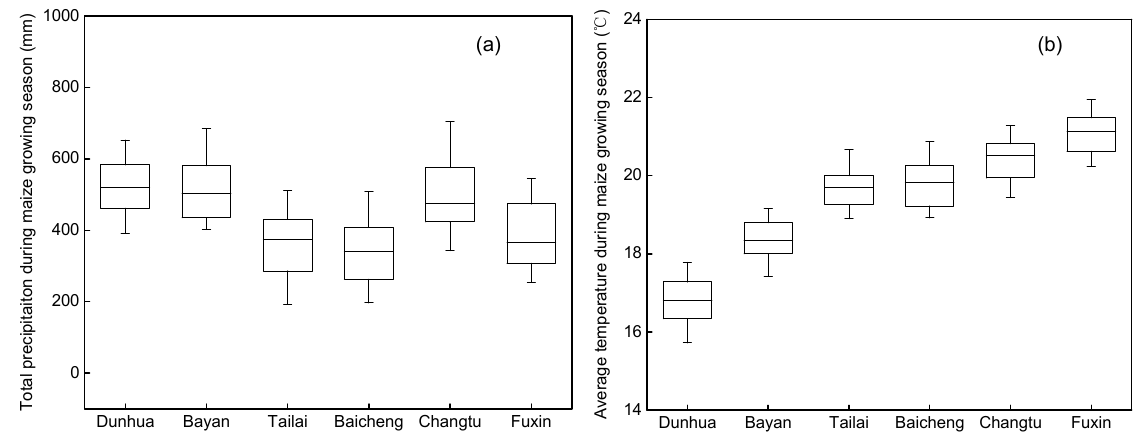
Table 2. The climatic regions classified by average temperature ( T ave ) and total precipitation ( p ) during the maize growing season from 1981 to 2018 in Northeast China.